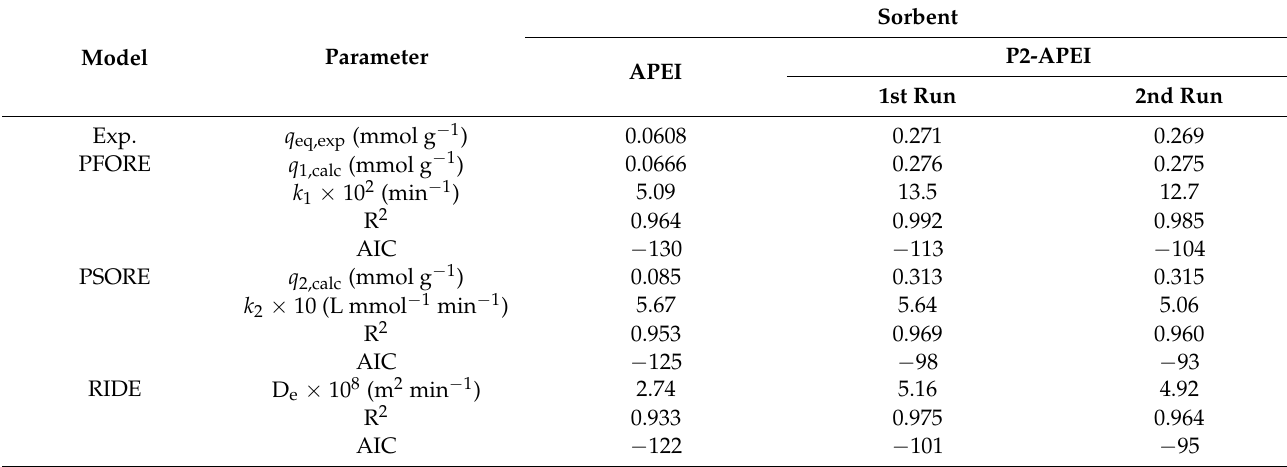
Sorbent P2-APEI APEI 1st Run 2nd Run